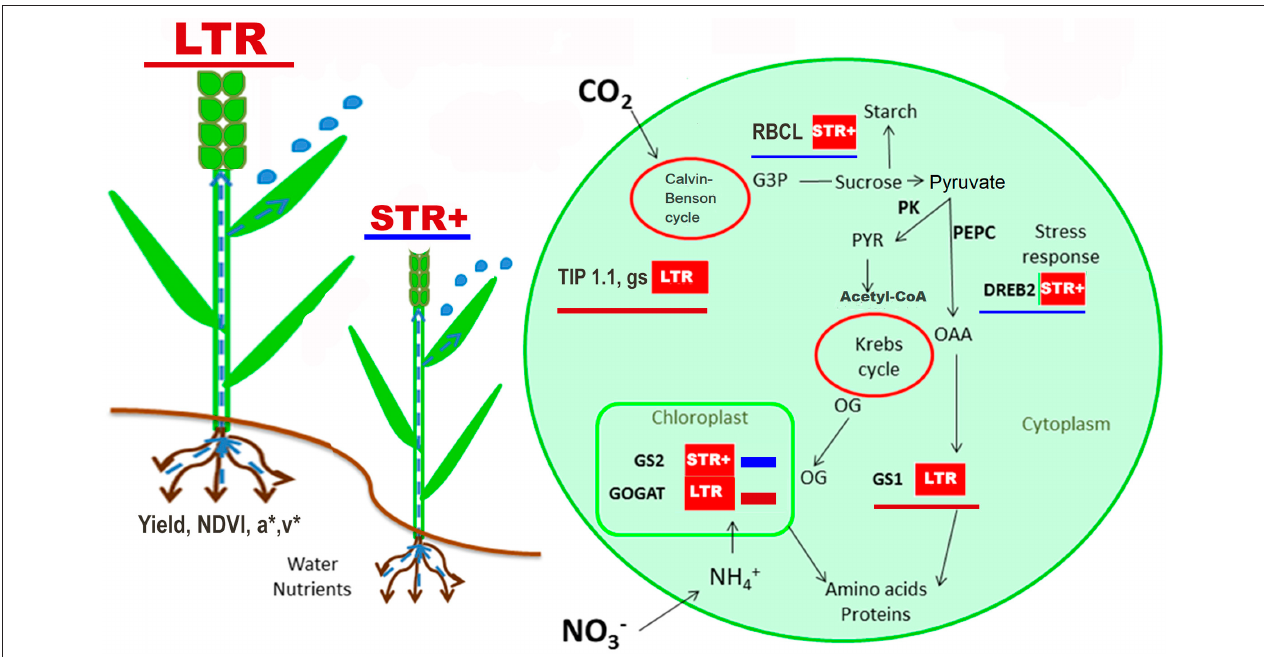
FIGURE 4 | Overview of the changes in physiological traits and gene expression between very segmented transpiration (STR + ) and linear transpiration (LTR) durum wheat lines. The scheme shows the significant mean expression of better or up-regulated values of LTR lines (red underline) and STR + lines (blue underline) as well as significant traits evaluated across all field trials and the integrated pathway of N and C metabolism. Data used corresponds to the 20 lines growth in the different yield environments (i.e., trials) where gene expression was analyzed, with three biological replicates (i.e., three plots of each trial) for each line and yield environment. For trait and transcript abbreviations see Tables 4, 5